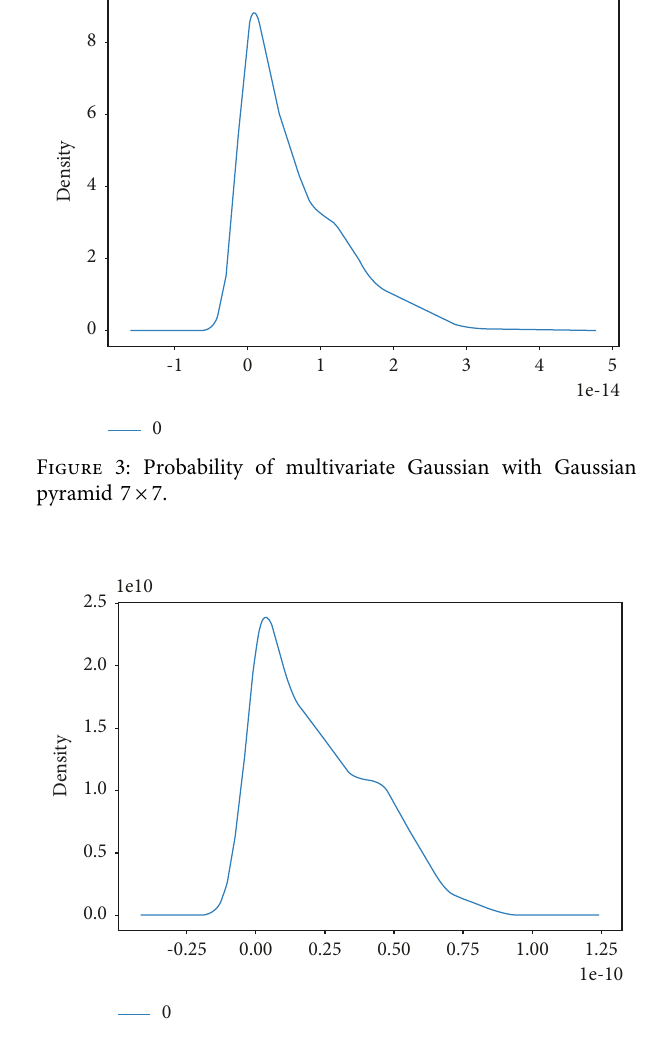
Figure 4: Probability of multivariate Gaussian with Gaussian pyramid 9 × 9.